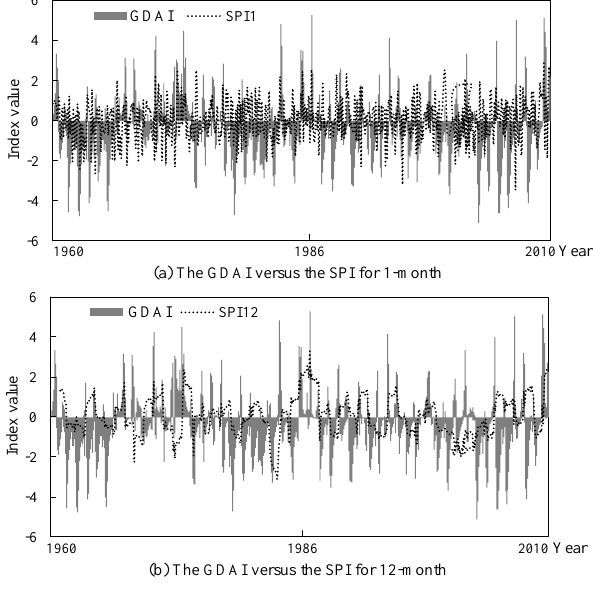
Figure 8. Compared the GDAI with the SPI in Lishu County from 1960 to 2010.